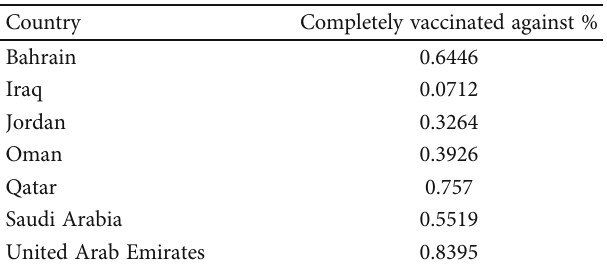
Table 2: Percentage of person completely vaccinated against COVID-19 in the Arabian Peninsula